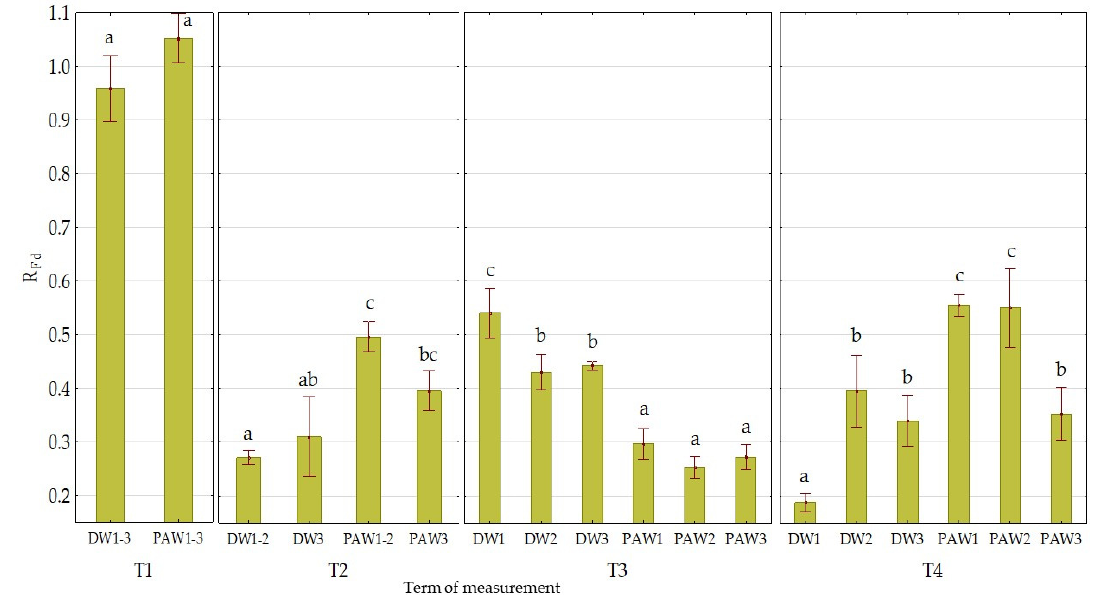
Figure 5. Change of Fluorescence decrease ratio ( R Fd ) after PAW application over time. The mean values (n = 8) sharing the same lowercase letter are not significantly different from each other ( p ≤ 0.05) according to the LSD test (each term was evaluated separately). Intervals present the mean standard error (SE).